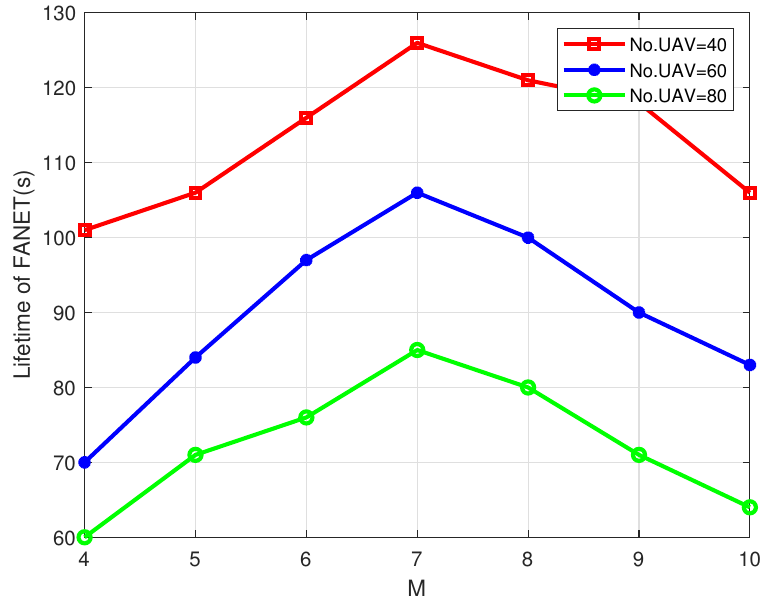
Figure 8. Lifetime of FANET in different numbers of UAV nodes versus the number of intervals M .